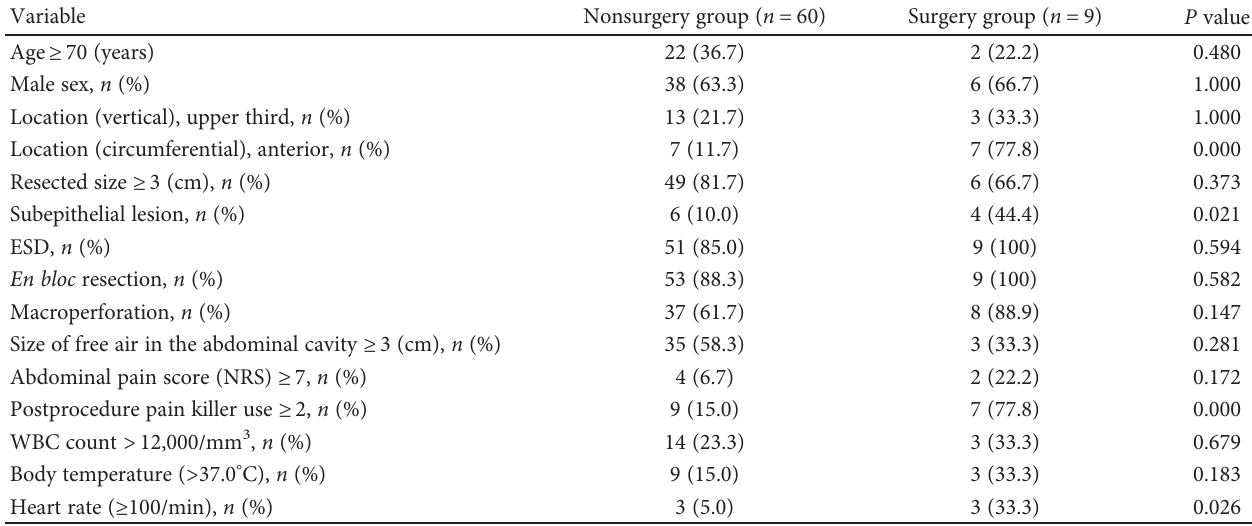
Table 3: A univariate analysis of variables associated with surgery caused by gastric perforation after endoscopic resection. Variable Nonsurgery group ( n = 60